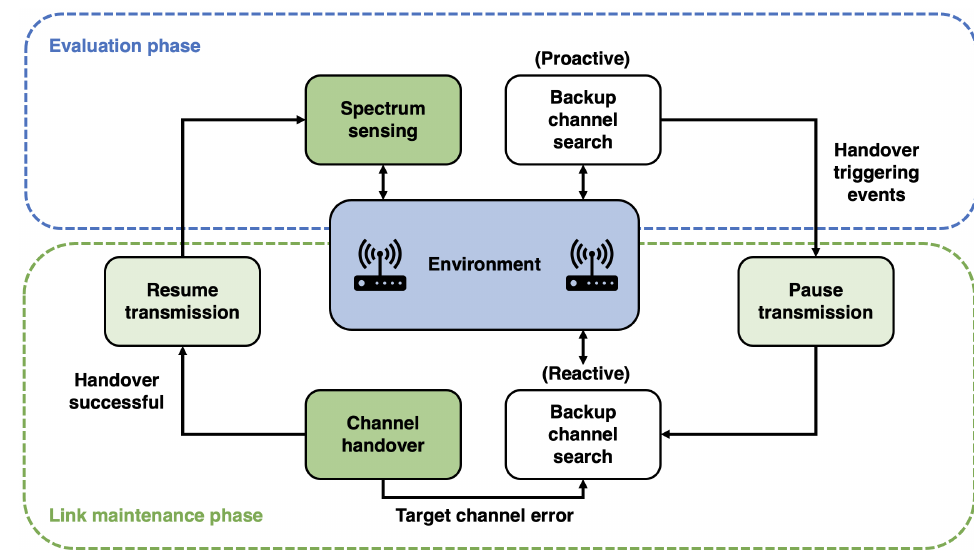
Figure 5. Spectrum handover process. Adapted from the work in